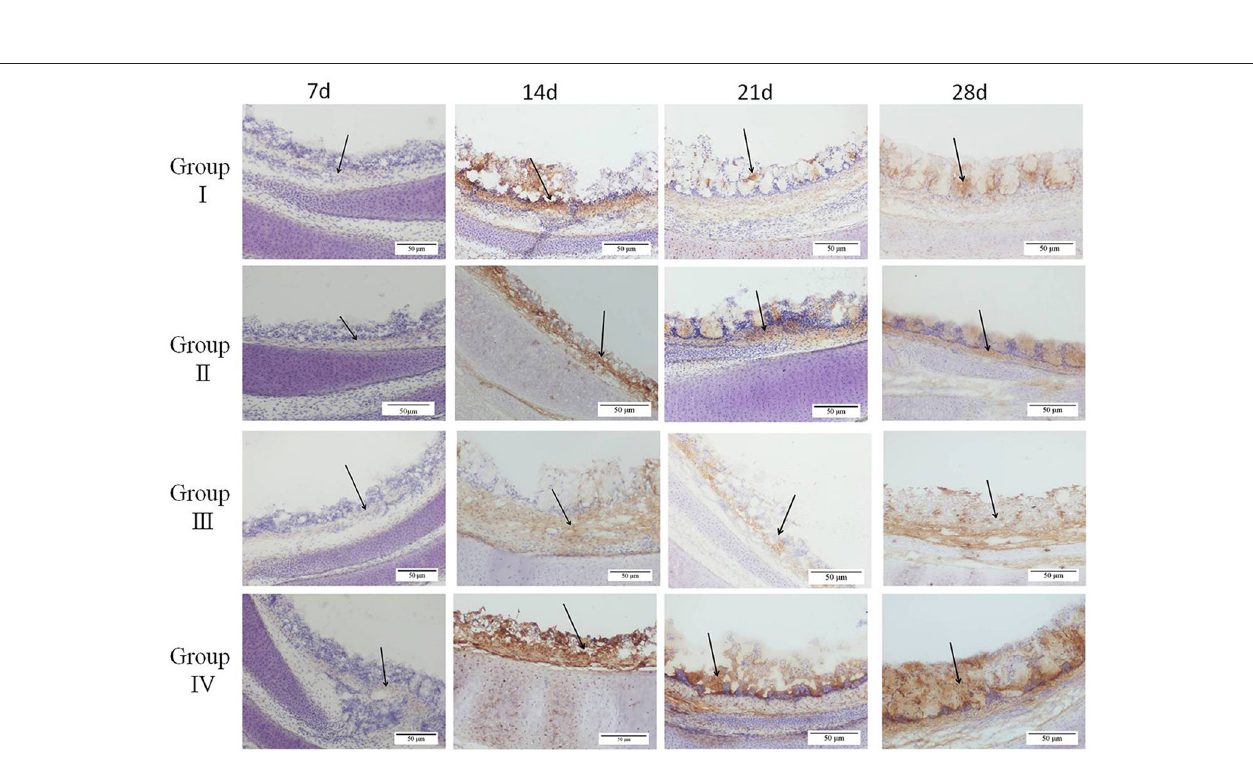
FIGURE 3 | Effect of doxycycline or SGDL granule and both on IgA + cells in the tracheal mucosa of chickens by immunohistochemical detection. Group I served as a control. Broilers in Group II were given doxycycline whereas Group III was given SGDL granule through drinking water. Broilers in Group IV were given SGDL granule and doxycycline in drinking water. Magnification, × 200. Black arrows indicate positive cells. SGDL, Shegandilong.